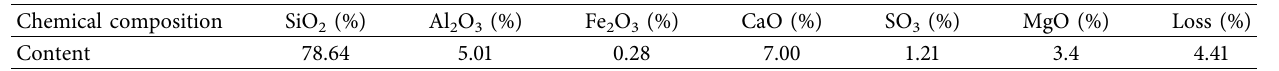
Table 3: Chemical composition of slag powder.